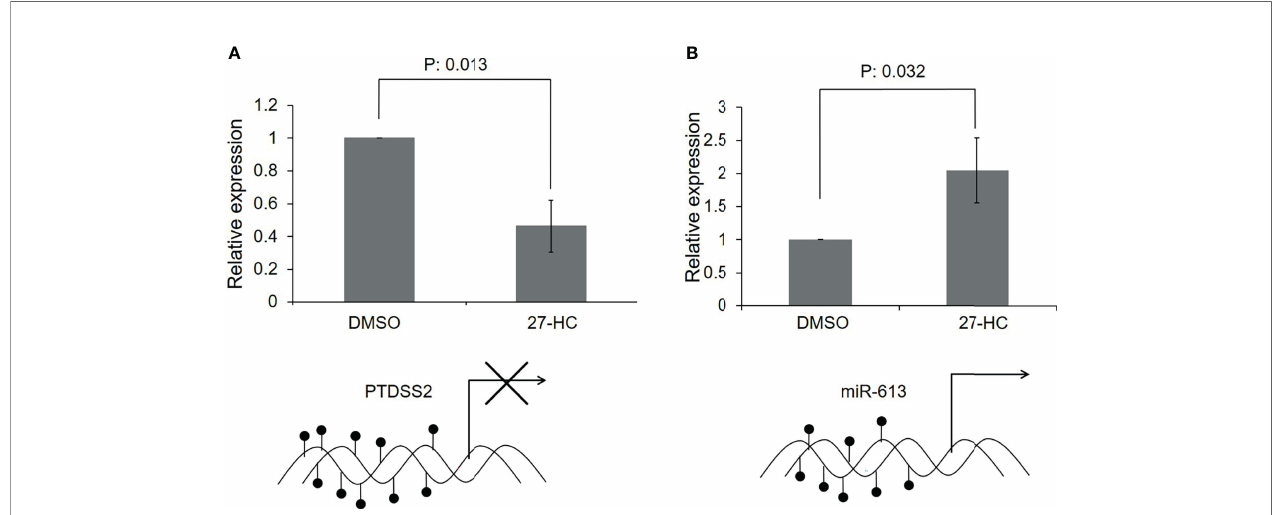
FIGURE 5 | Transcriptional regulation of 27-hydroxycholesterol (27-HC)-mediated DNA hypermethylation: (A) The bar graph represents the qRT-PCR analysis for PTDSS2 and has revealed the downregulation of its expression in 27-HC-treated cells. The GAPDH was used as normalization control, and the error bar represents the standard deviation of three independent replicates. The bottom scheme represents the hypermethylation of PTDSS2 gene promoter leading to transcriptional repression. (B) The qRT-PCR analysis has revealed the biogenesis of miR-613 microRNA in 27-HC-treated cells. The U6 miRNA was used as internal normalization control to measure the relative expression of the miR-613 , and the error bar represents the standard deviation of three independent replicates. The scheme at the bottom of the bar graph represents the hypermethylation of mir-613 gene promoters, leading to transcriptional activation and biogenesis of miR-613. The p values were calculated using paired t-test, and the p values < 0.05 were considered signi fi